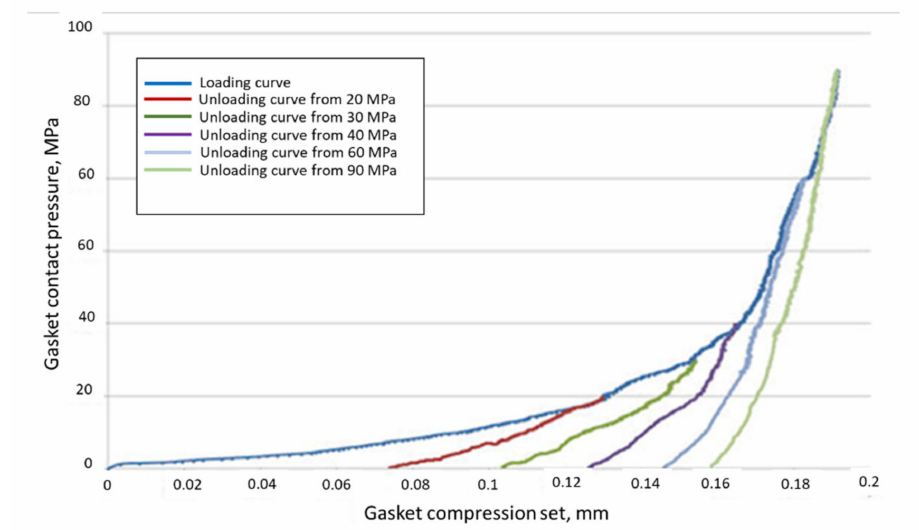
Figure 10. Elastic characteristics of a 2-mm-thick fibre–elastomer gasket.